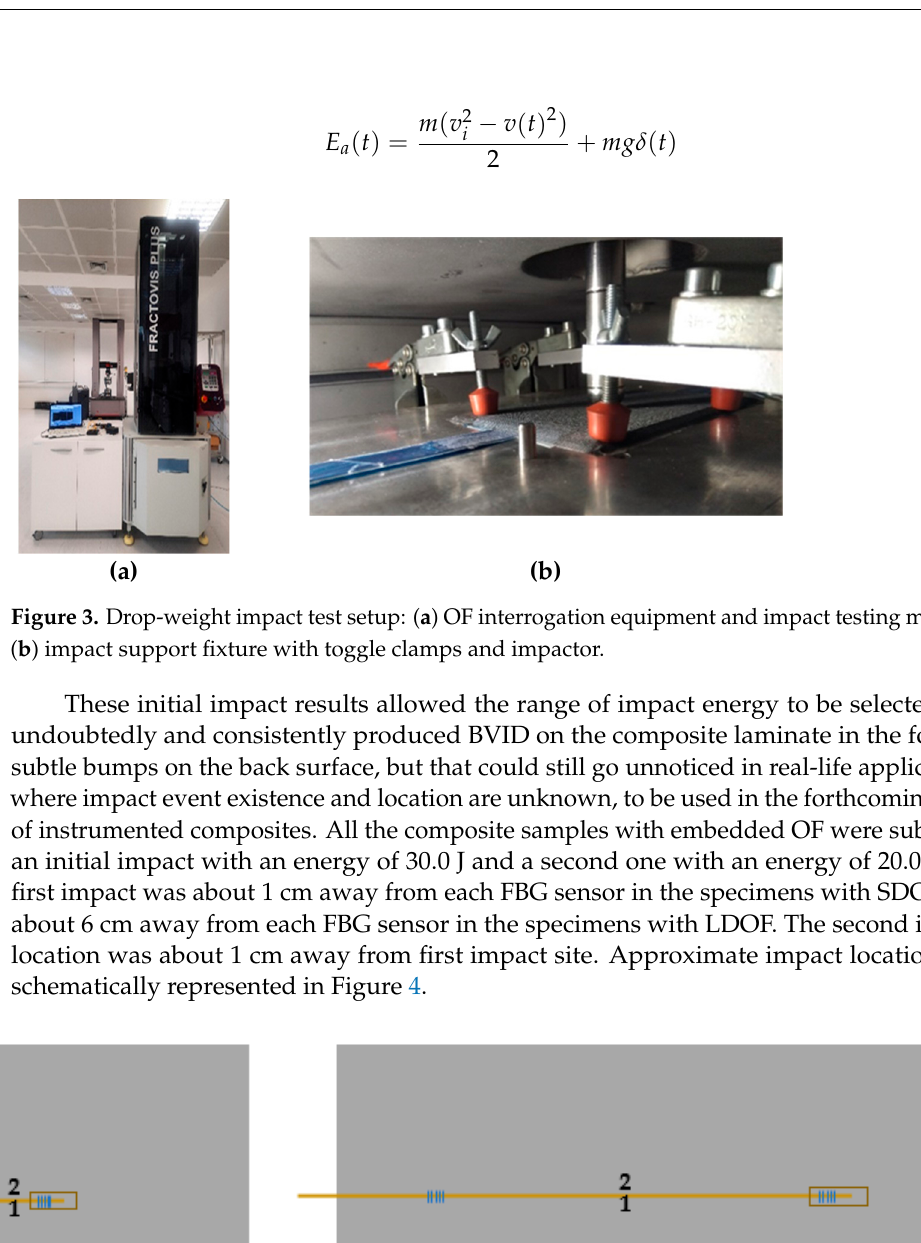
Figure 3. Drop-weight impact test setup: ( a ) OF interrogation equipment and impact testing machine; ( b ) impact support fixture with toggle clamps and impactor.